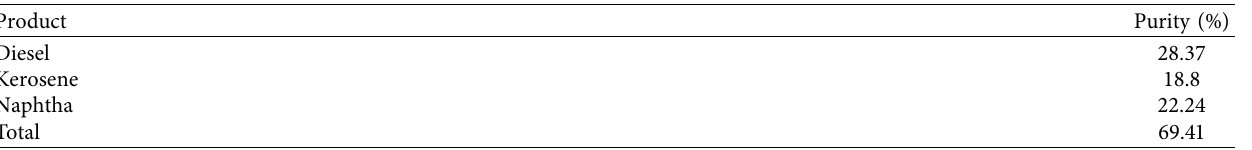
Figure 7: Process parameters of optimisation results: (a) particle diameter, (b) gas inlet velocity, (c) feed molar ratio, and (d) inlet temperature. Table 6: Purity of products at 500 ° C.